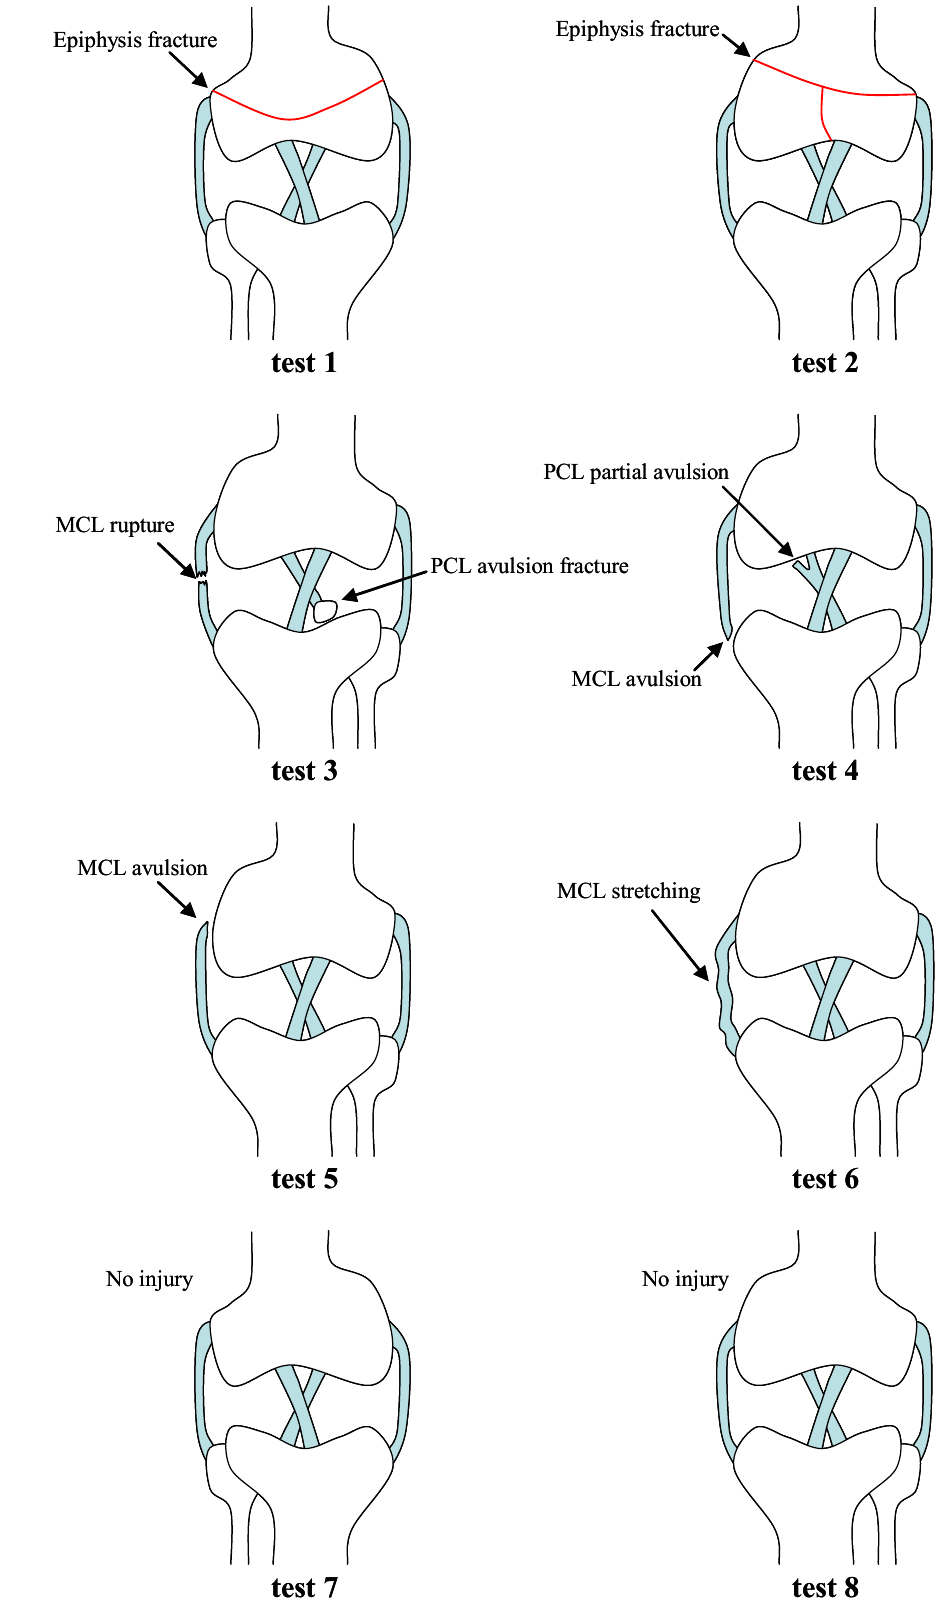
Fig. 3 Schematic injury description of specimens (front view of knee